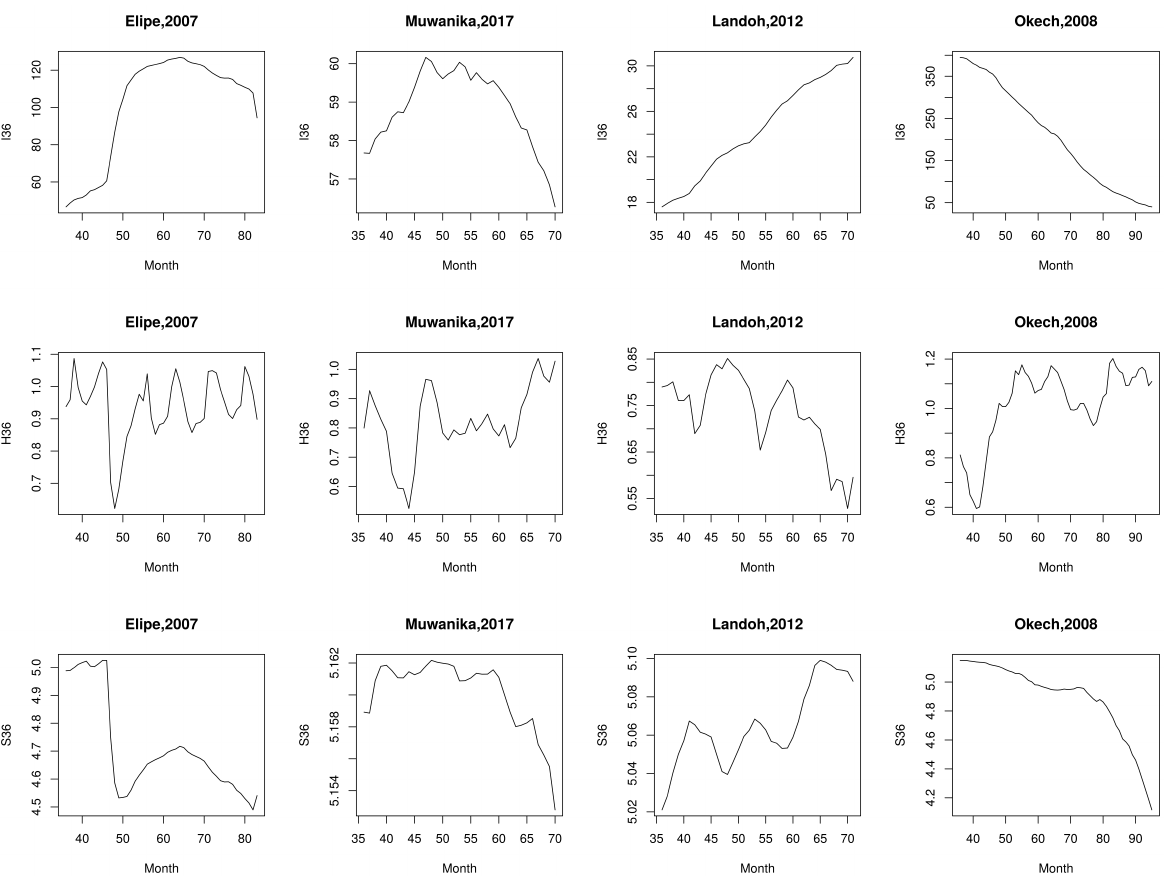
Figure A4. (Cont. Figure A3): Gomez-Elipe et al. (Karuzi in Burundi, 2007) [24], Muwanika et al. (Uganda, 2017) [26], Landoh et al. (Est Mono district in Togo, 2012) [25], Okech et al. (Kenya, 2008) [27].